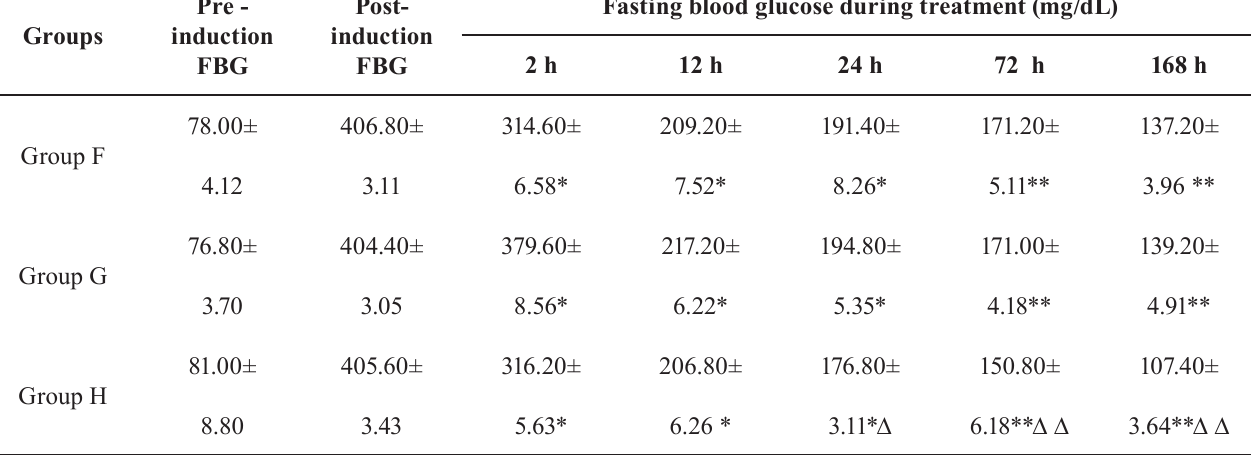
Table- II - Fa sting blood glucose levels (mg/dL)in mice (n=5) at different time intervals during treatment